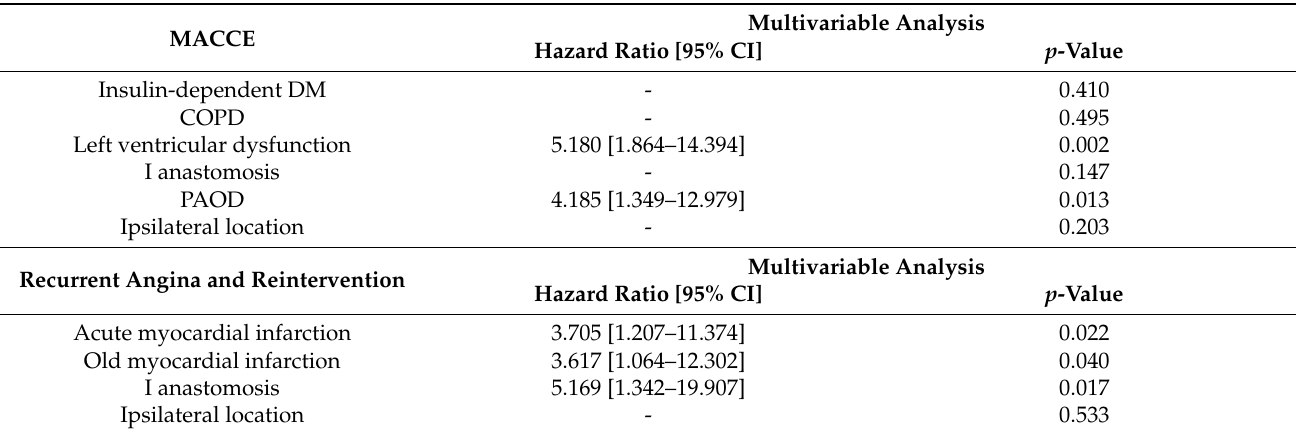
Table 4. Risk factor analysis (unadjusted